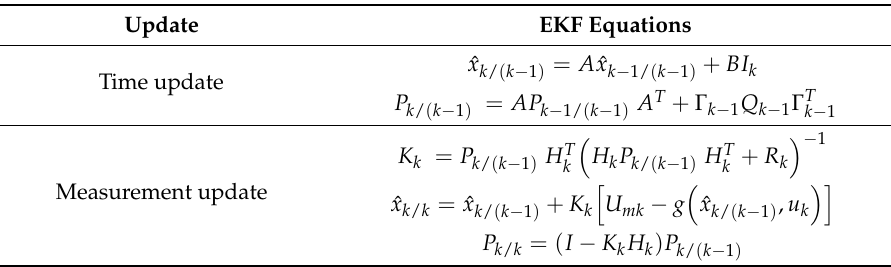
Table 1. Extended Kalman filter (EKF) equations.